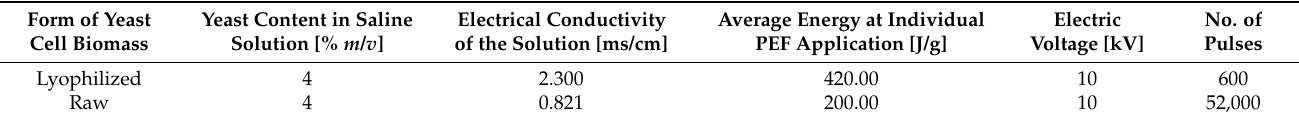
Table 2. Conditions for the application of a pulsed electric field.